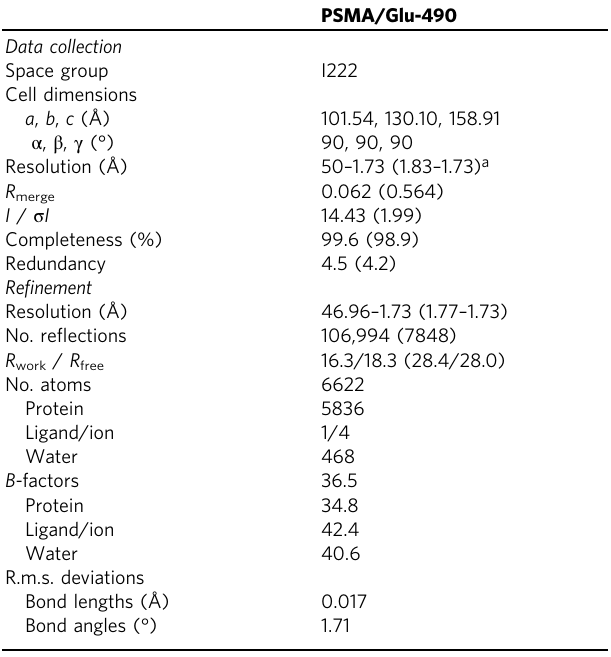
Table 1 Data collection and re fi nement